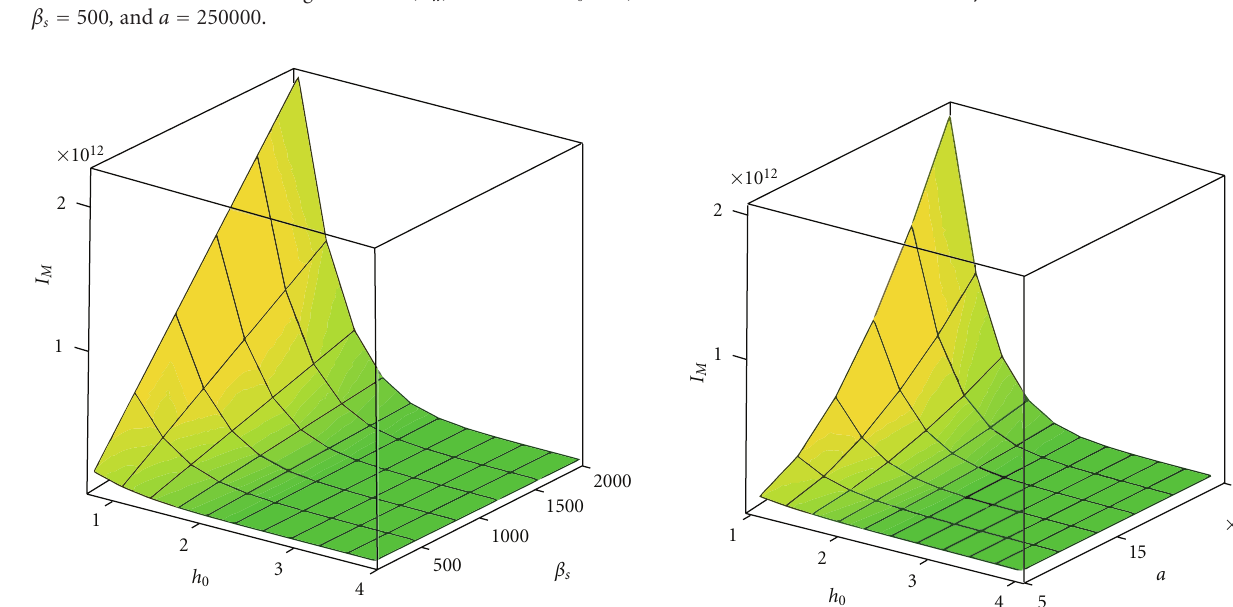
Figure 14: I M ( h 0 , m ) for β s = 500 and a = 150000.